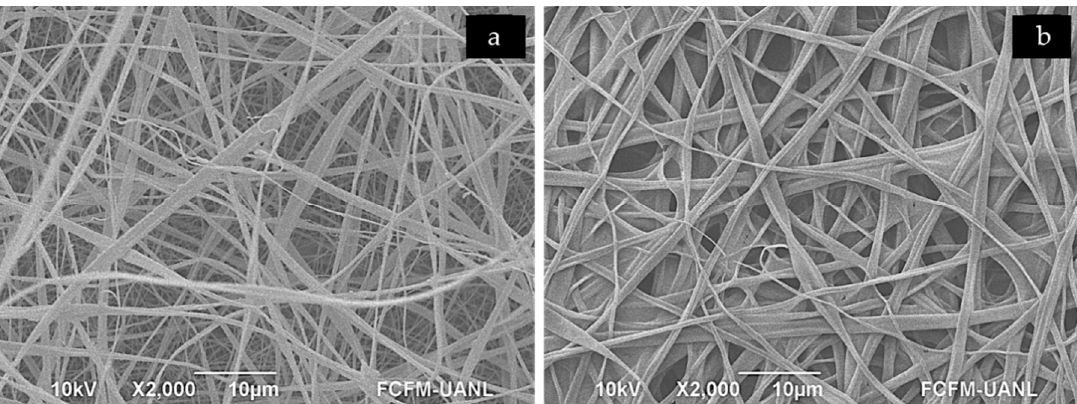
Figure 4. SEM images showing the morphology of the ( a ) scaffold CA layer fibers and the changes it suffered after ( b ) scaffold CA layer was exposed to water.